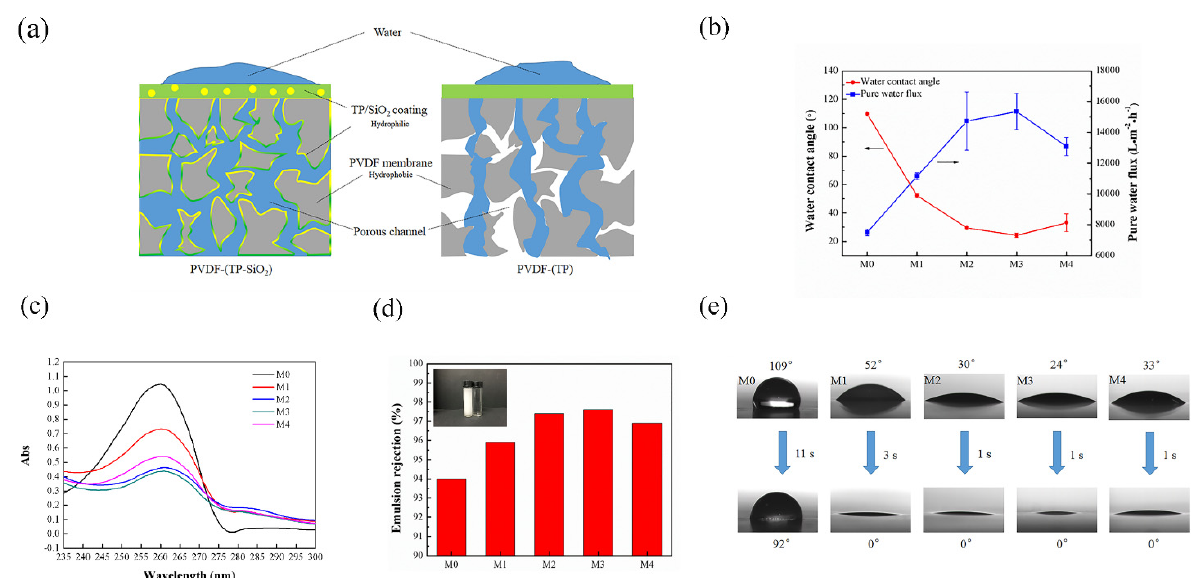
Figure 3. ( a ) The mechanism of water passing through the modified membrane, ( b ) Water contact angle and pure water flux of modified membrane, ( c ) UV-Vis spectra of the toluene emulsion filtrate of modified membrane, ( d ) Emulsion rejection of modified membrane, ( e ) Images of a water drop on different membranes.